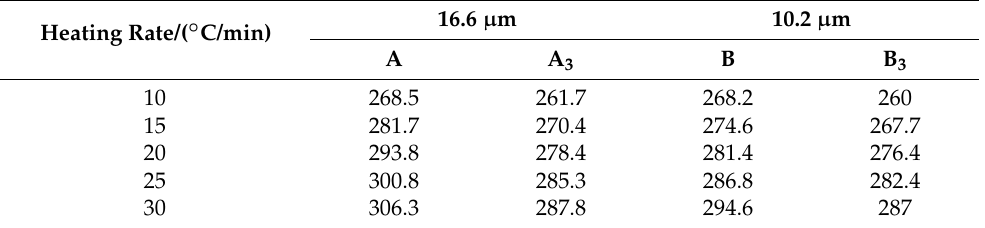
Table 3 . DSC data of plasticized spinning PAN fibers.